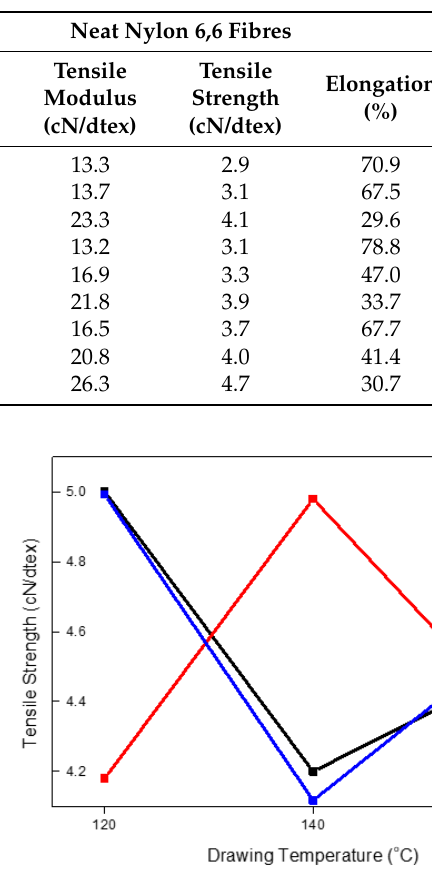
Table 3. Mechanical Properties of the Neat and Salt-confined Nylon 6,6 Fibres.